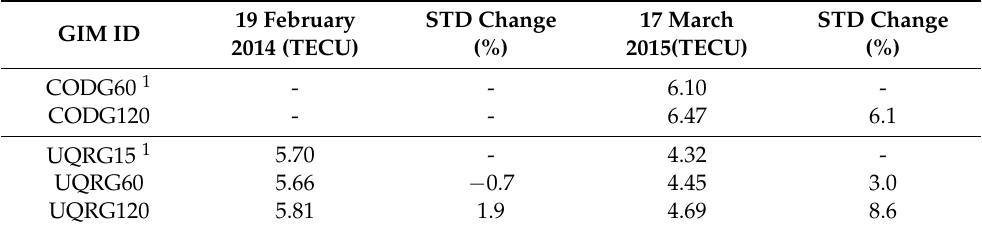
Table 7. Daily STD from Alt-VTEC comparisons during analyzed storms.